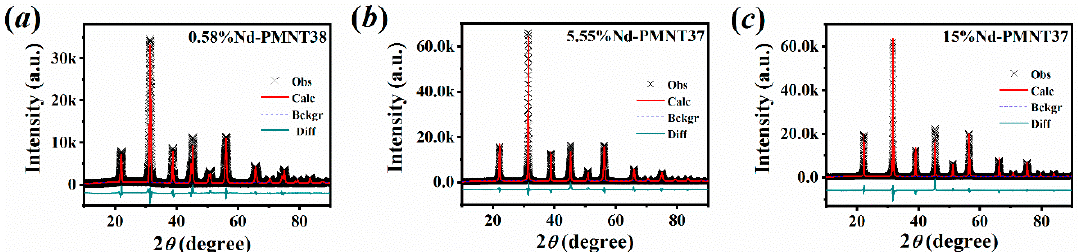
Figure 2. ( a – c ) XRD patterns of Nd-PMNT crystalline powders were refined by the Rietveld Figure 2. ( a–c ) XRD patterns of Nd ‐ PMNT crystalline powders were refined by the Rietveld method. method. Experimental, fitted, di ff erences curves are shown by crosses, red solid and green solid Experimental, fitted, differences curves are shown by crosses, red solid and green solid curves, curves, respectively.